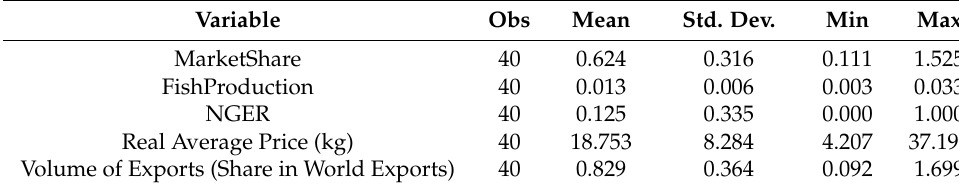
Table 1. Descriptive